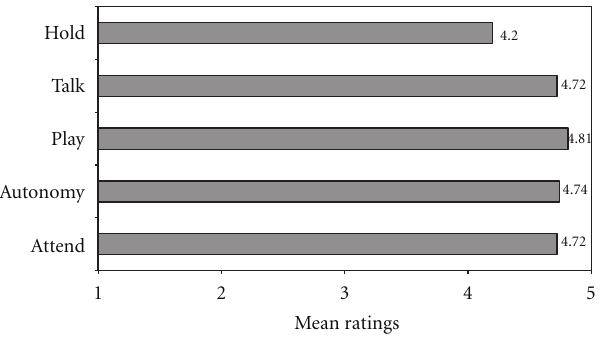
Figure 1: Mean ratings (1 = never to 5 = always) for caregivers’ involvement in childcare